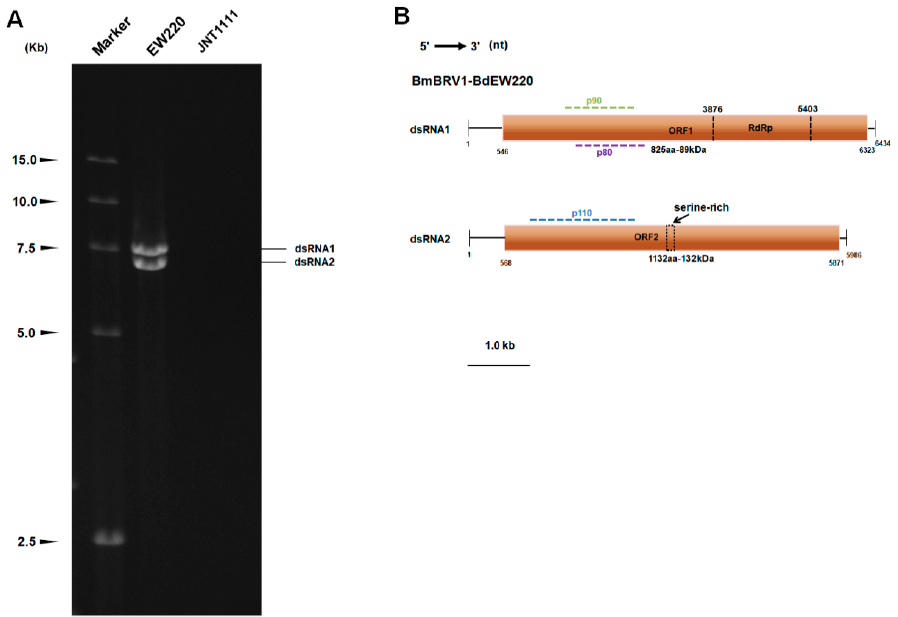
Figure 2. Double-stranded RNAs extracted from strain EW220 and the genomic organization of Botryosphaeria dothidea botybirnavirus 1 (BmBRV1-BdEW220). ( A ) One percent agarose gel electrophoretic profiles of dsRNA preparations extracted from strains EW220 and JNT1111 after digestion with DNase I and S1 nuclease; ( B ) schematic diagrams of the genomic organization of